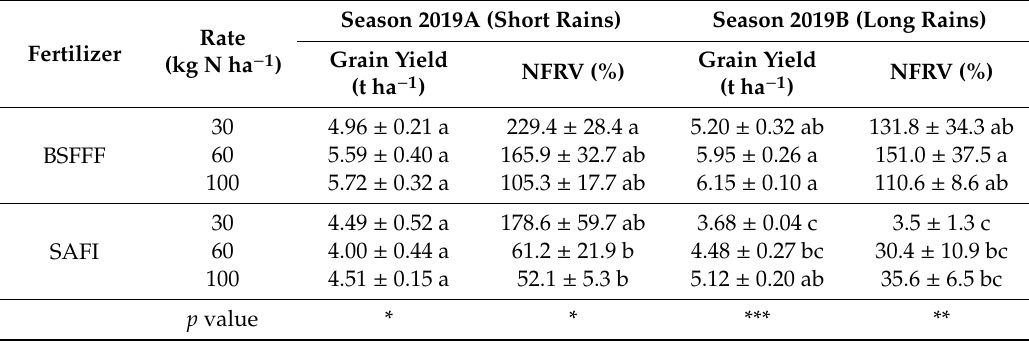
Table 3. Maize grain yield and nitrogen fertilizer replacement values of BSF frass and SAFI organic fertilizers.